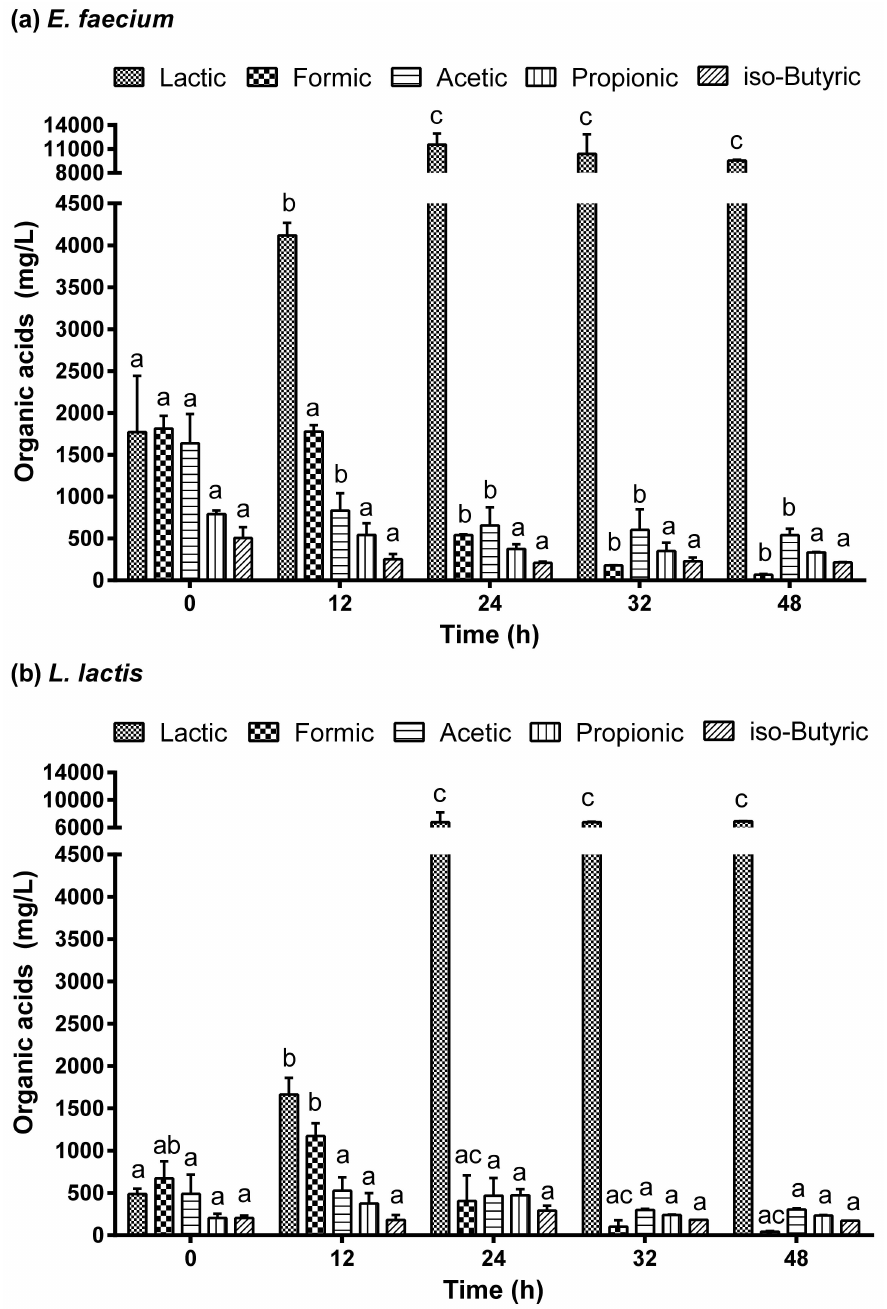
Figure 5. Organic acids profile during fermentation of Aloe vera extract with Enterococcus faecium ( a ) and Lactococcus lactis ( b ). Different letters a–c show significant differences ( p < 0.05) between different fermentation times for the same organic